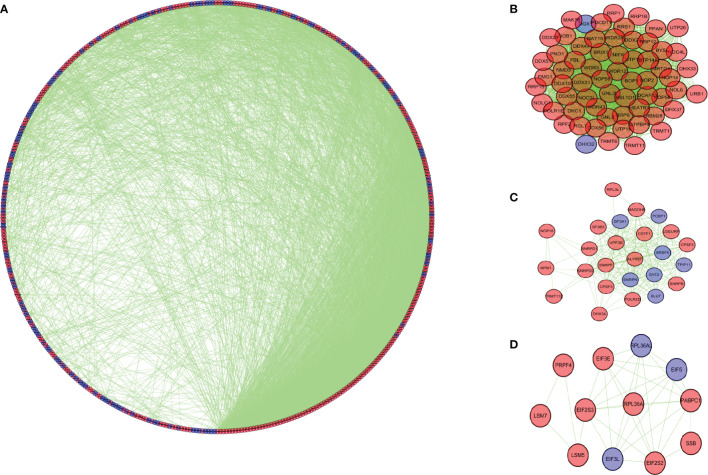
Protein-protein interaction network and modules analysis. (A) Protein-protein interaction network of differentially expressed RBPs. (B) Module 1 in PPI network. (C) Module 2 in PPI network. (D) Module 3 in PPI network. Blue circles: down-regulation; red circles: up-regulation.